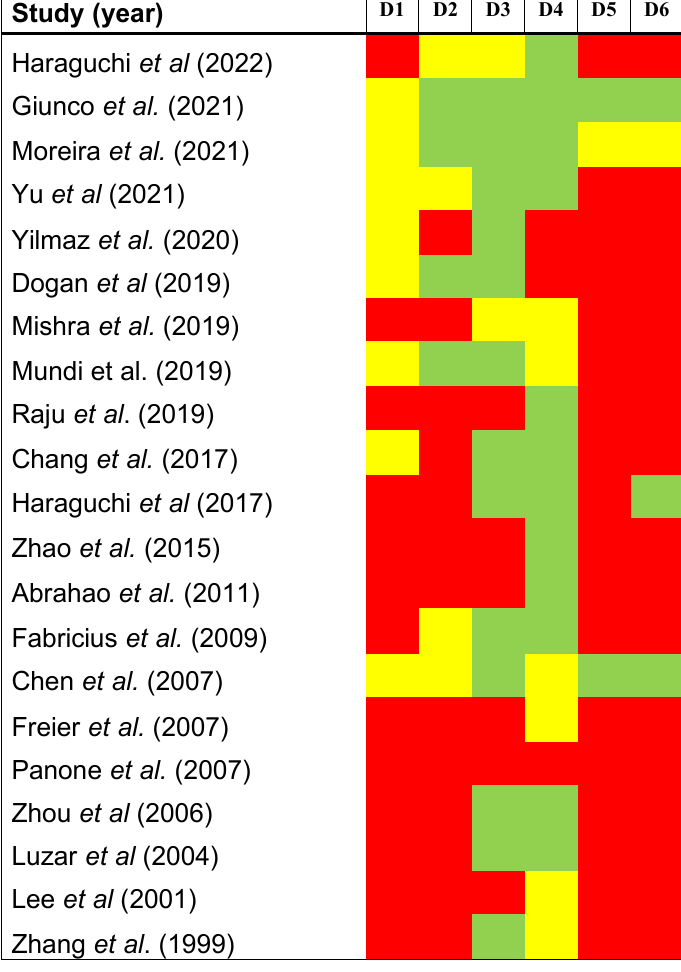
Figure 2. Quality plot depicting the risk of potential bias across primary-level studies, assessed using the Quality in Prognosis Studies tool (QUIPS) developed by the Cochrane Prognosis Methods Group, which considers the following domains: (D1) study participation, (d2) study attrition, (d3) prognostic factor measurement, (d4) outcome measurement, (d5) study confounding, and (d6) statistical analysis and reporting. Risk of bias was classified as low (green), moderate (yellow), or high (red) for each domain.